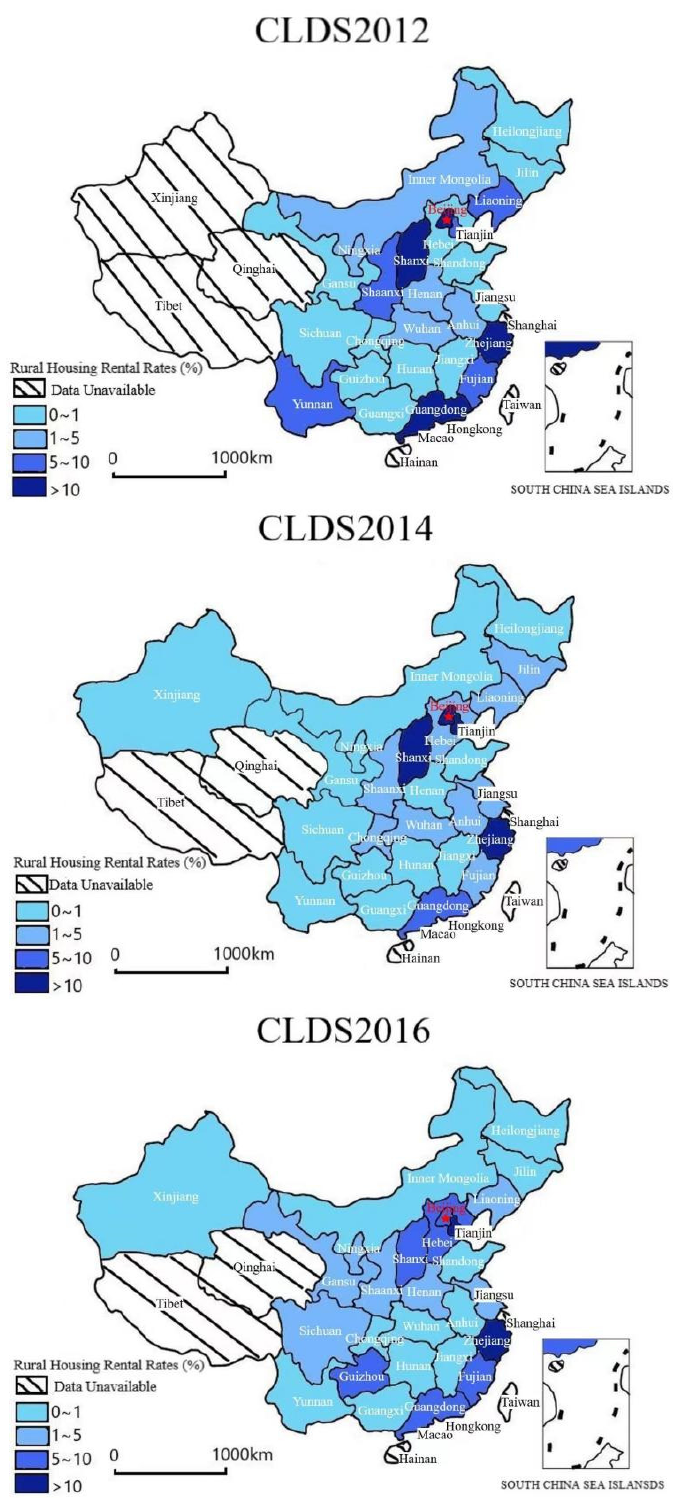
Figure 2. Spatial pattern of China’s rural housing rental rate. First, rural housing rental behavior (rural housing rental rate > 0) exists in the vast majority of provinces nationwide, indicating that the basic function of rural housing has, in fact, broken through the limits of the residential security attributes. In not only eastern